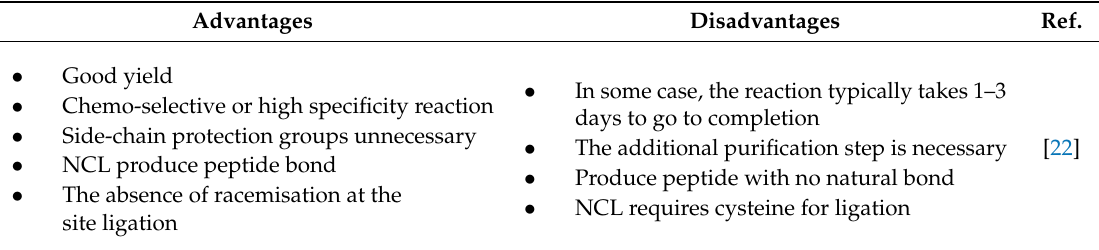
Table 3. Advantages and disadvantages of chemical ligation.